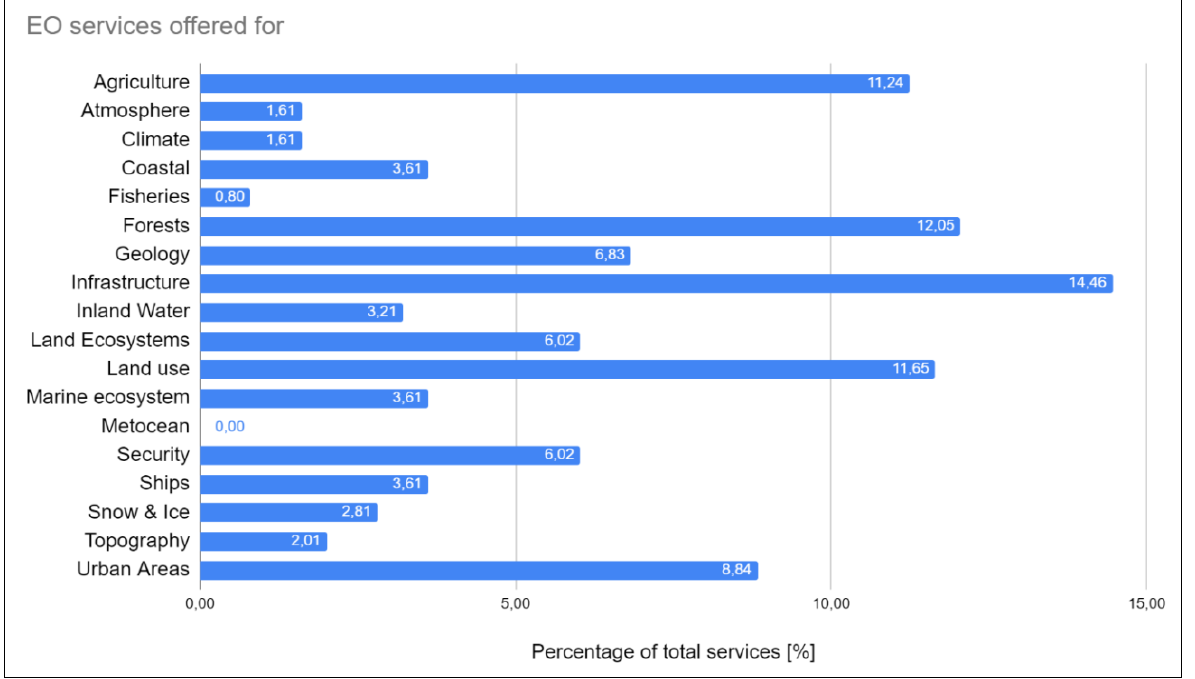
Figure 9. EO services offered under the different subdomains.